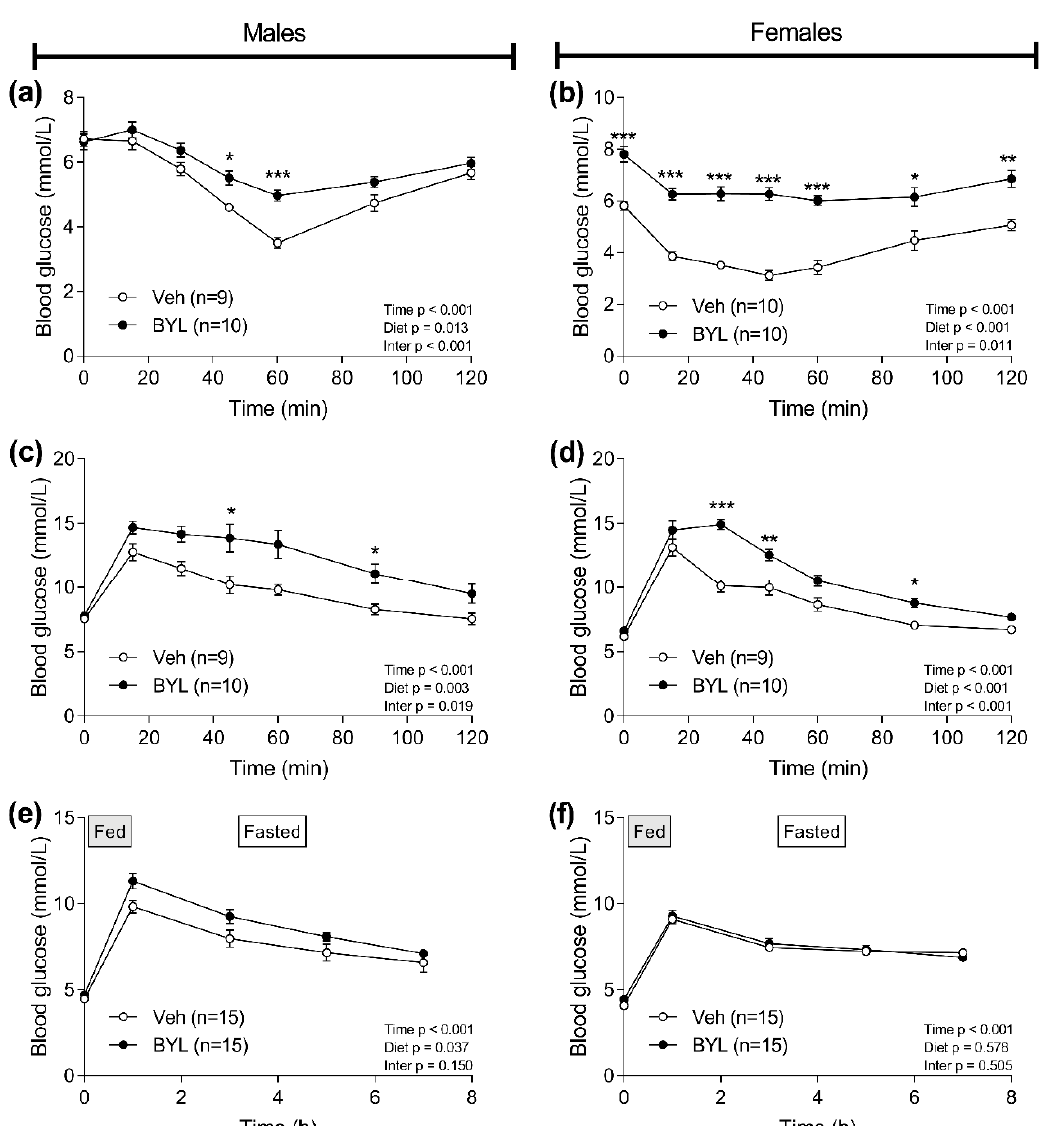
Figure 5. Glucose ( a , b ) and insulin tolerance tests ( c , d ), and blood glucose response to a meal challenge ( e , f ) of male and female middle-aged mice following 6 weeks of receiving a control- (Veh; vehicle) or BYL719 (BYL)-containing diet. Data are presented as mean ± SE, statistical analysis was by two-way repeated measures ANOVA with Sidak post-hoc. * p < 0.05, ** p < 0.01, *** p < 0.001 vs. Veh.